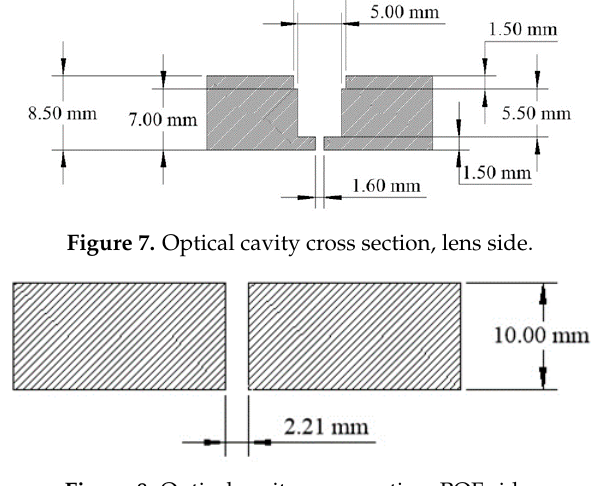
Figure 8. Optical cavity cross section, POF side.